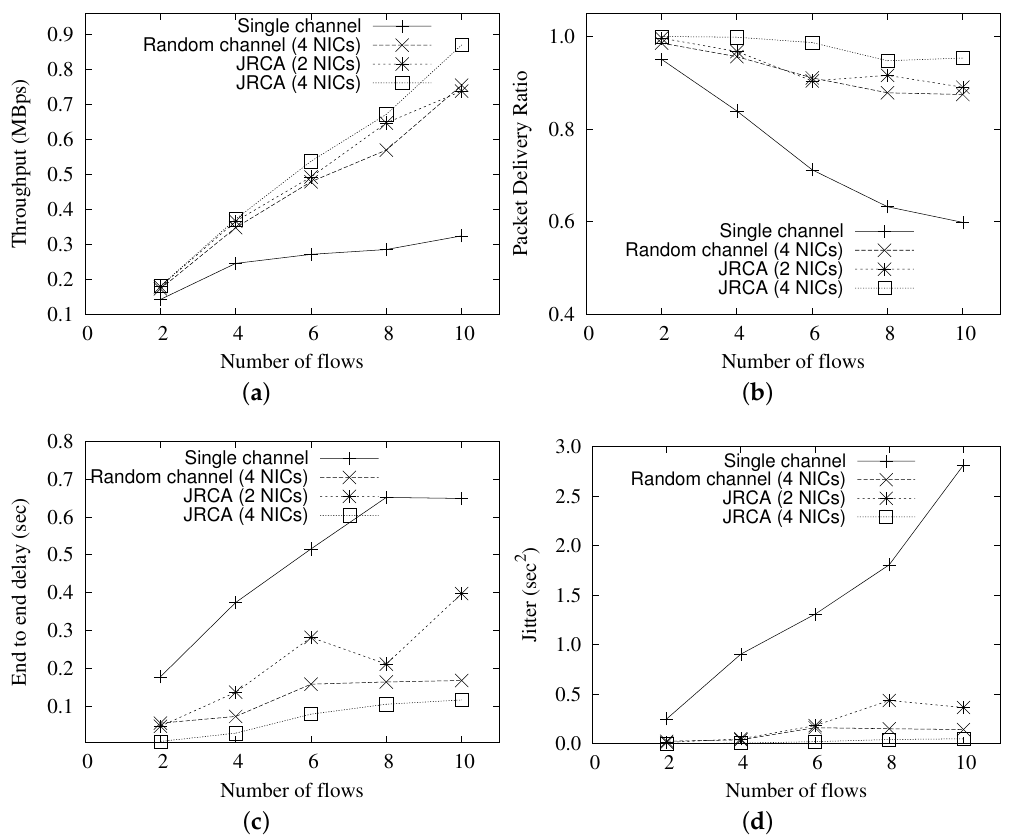
Figure 9. Comparison of ( a ) throughput ( b ) delivery ratio ( c ) delay ( d ) jitter with different number of flows for multi-channel WOBAN with multiple